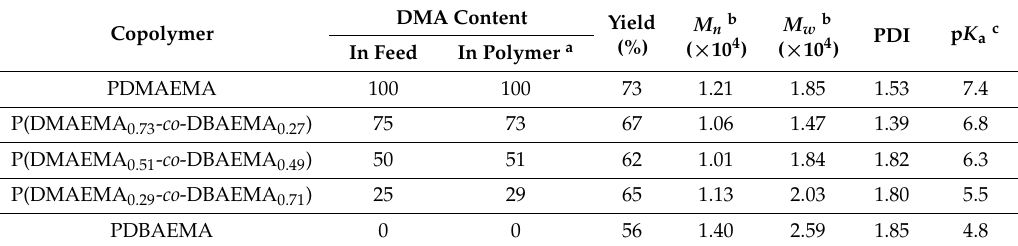
Table 1. Characterization of (co)polymers.